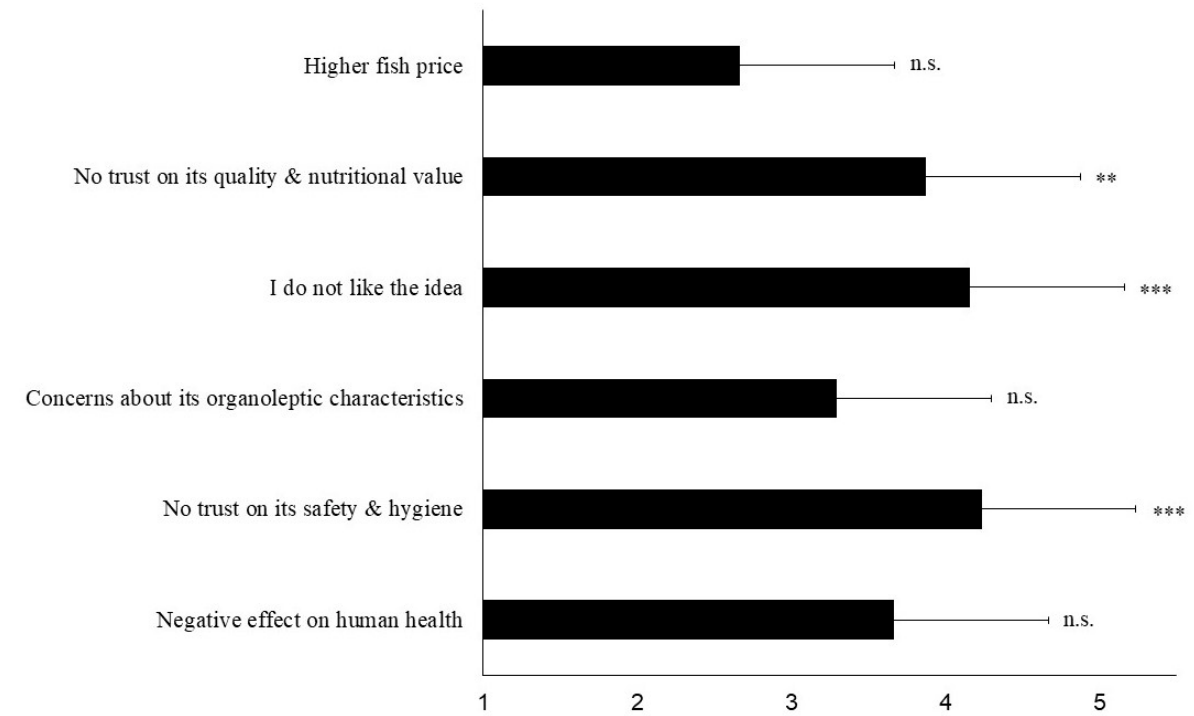
Figure 3. Mean attribute perception scores ( ± Standard Deviation) among participants not willing to consume fish fed with insects for the main reasons that dictate their attitude. Answers were given on a five-point Likert scale with response categories ‘1 = strongly disagree’, ‘2 = disagree’, ‘3 = neutral’, ‘4 = agree’, ‘5 = strongly agree’ (n = 20). Asterisks denote statistical differences (** p < 0.01, *** p < 0.001) after an one-sample t-test with test value = 3; n.s.— not significant.